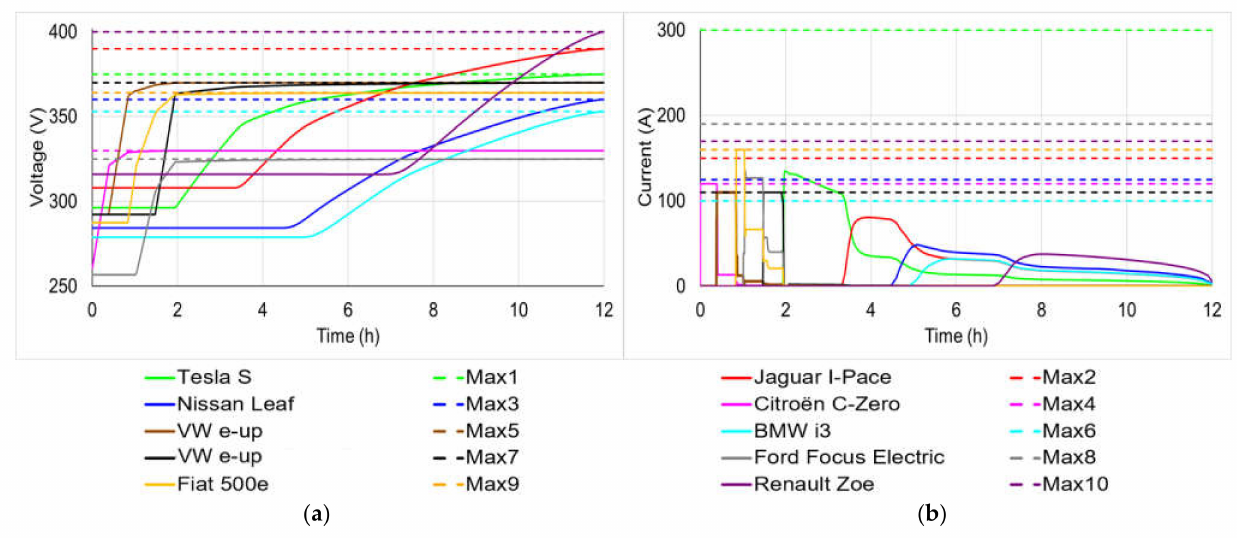
Figure 7. Battery terminal voltage ( a ) and current ( b ) of the EVs during charging for the third